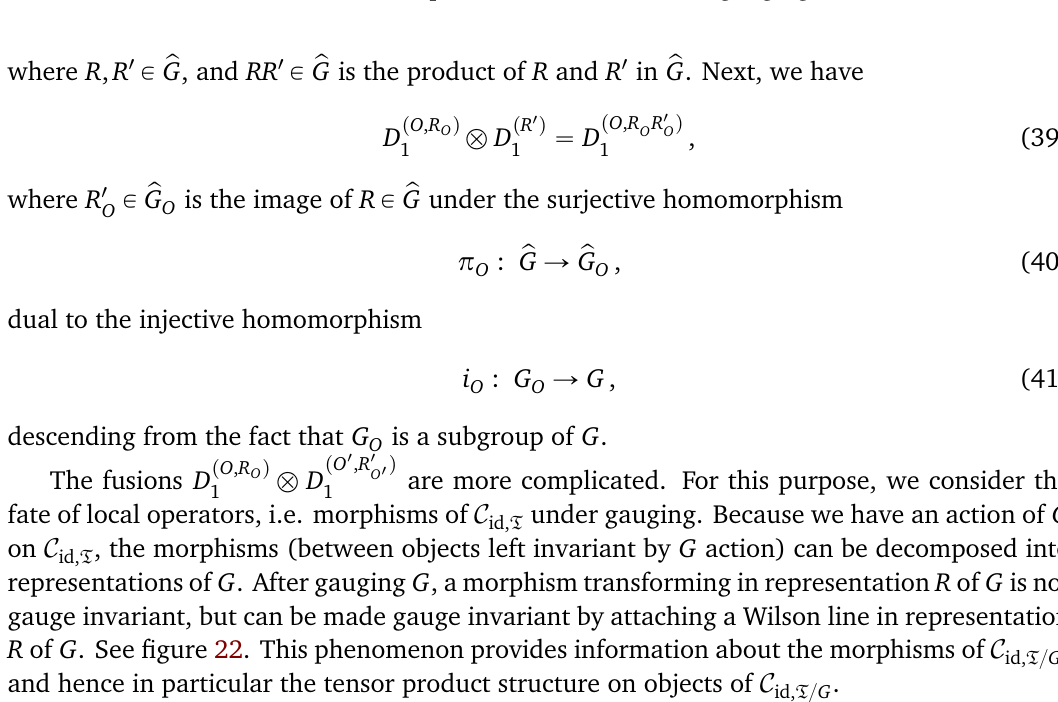
Figure 22: A local operator transforming in representation R of G before gauging G , is attached to a Wilson line in representation R of G after gauging G